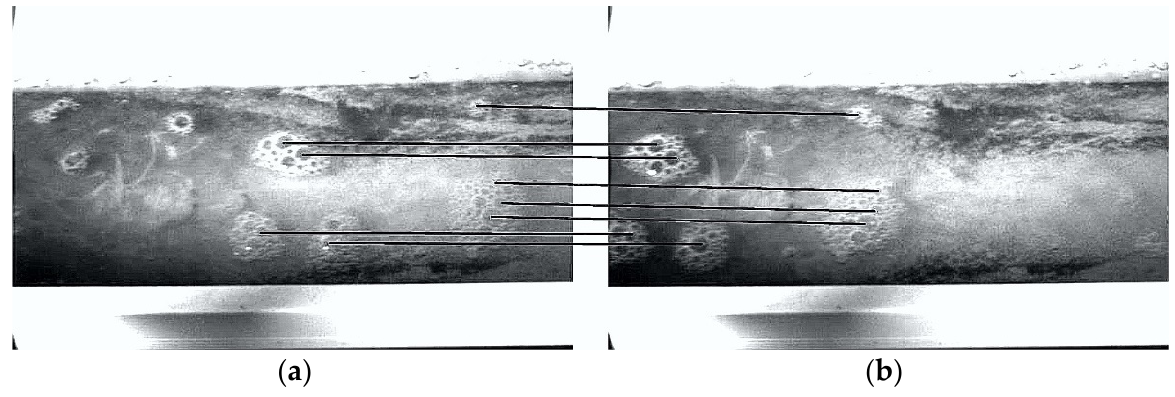
Figure 10. Matching point pairs manually labeled in 18th frame ( a ) and 28th frame ( b ).